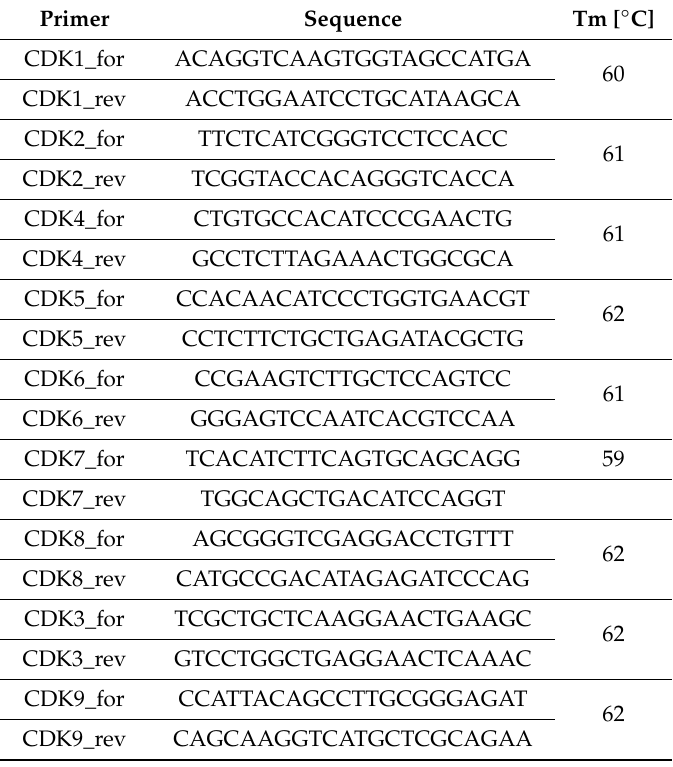
Table 3. The sequences and melting temperatures (Tm) of the primers used for qPCR.